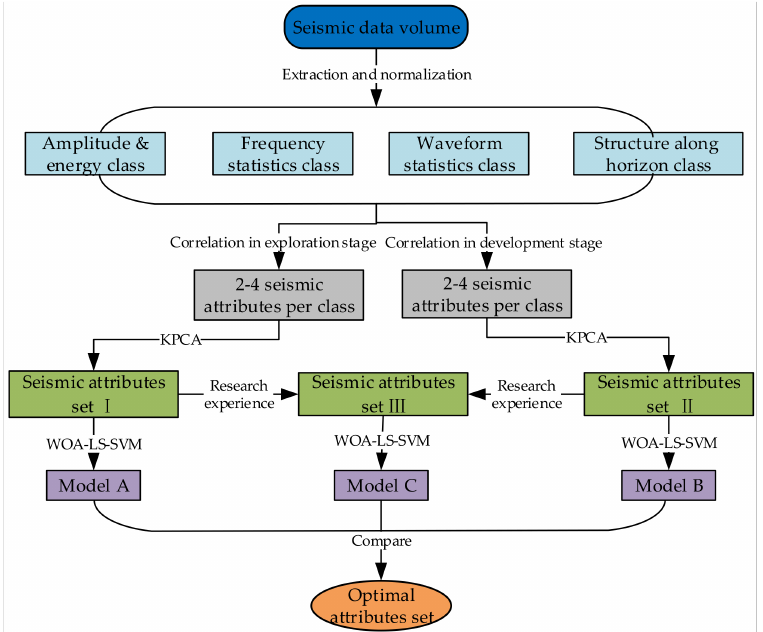
Figure 1. Flow chart of the comprehensive optimization framework for seismic attribute